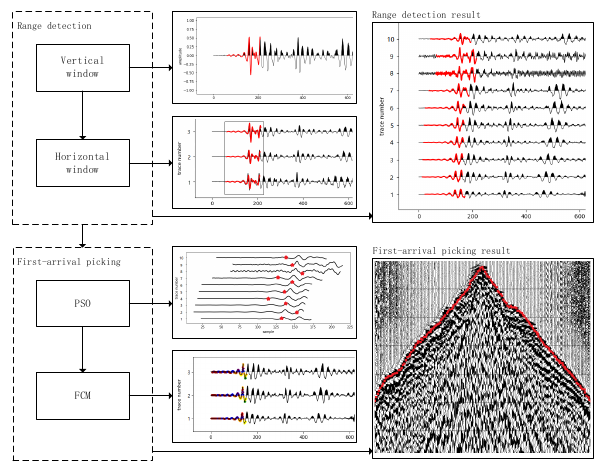
Figure 1. The framework of the FPSF algorithm (In the middle part, red indicates first-arrival intervals or initial clustering centers; In the right-top part, red indicates the first-arrival range; In the right-bottom part, red indicates first